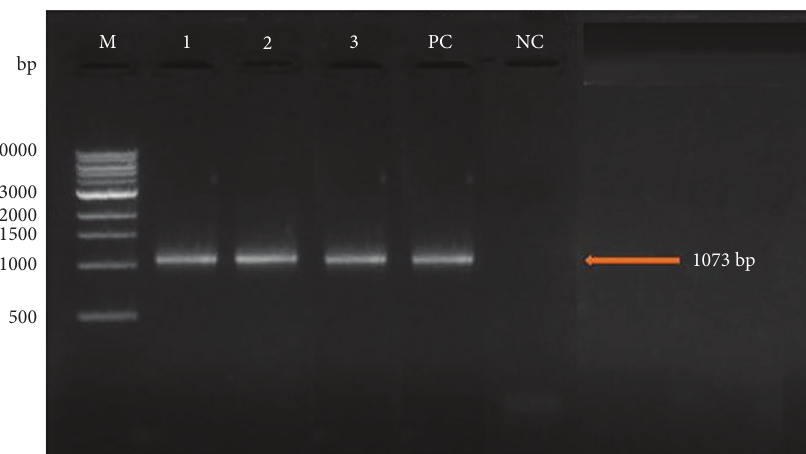
Figure 3: 1.5% gel electrophoresis showing detection of nested PCR products (1073bp) of the NADH-1 gene of E. granulosus . Lane M:1 kb molecular marker; lanes 1–3 are positive samples; lines PC and NC are positive control and negative control, respectively. 1 α